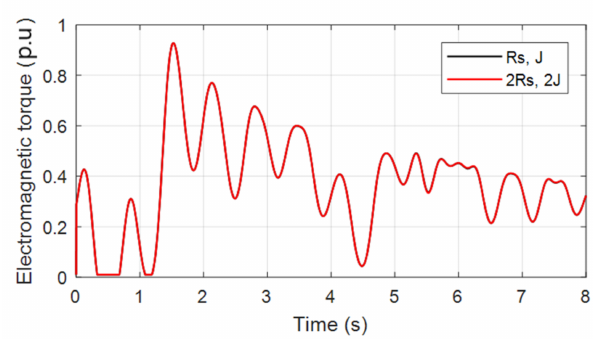
Figure 18. Electromagnetic torque.